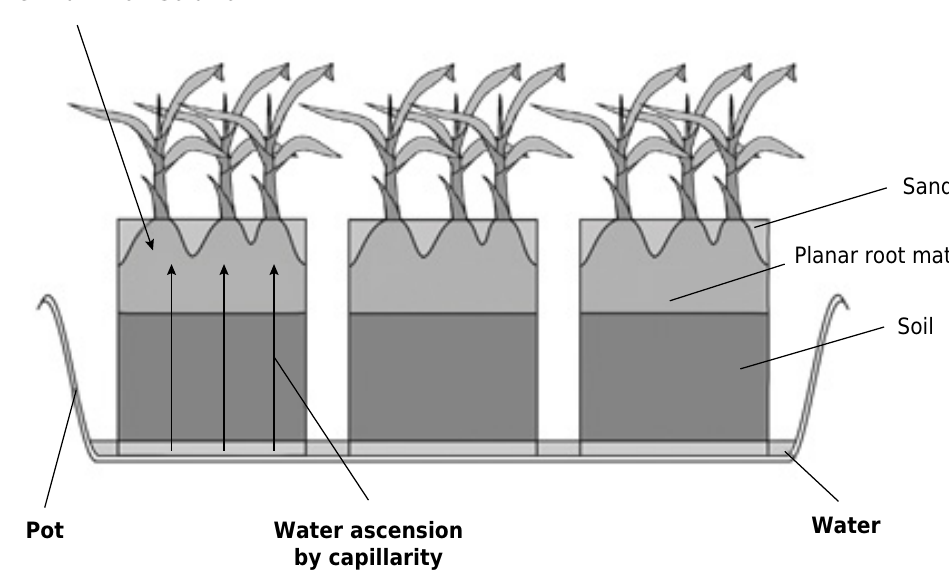
Figure 1. Plant growth containers